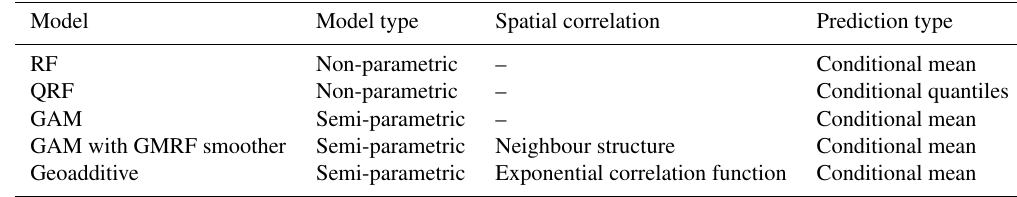
Table 1. Summary of the regression models tested in this